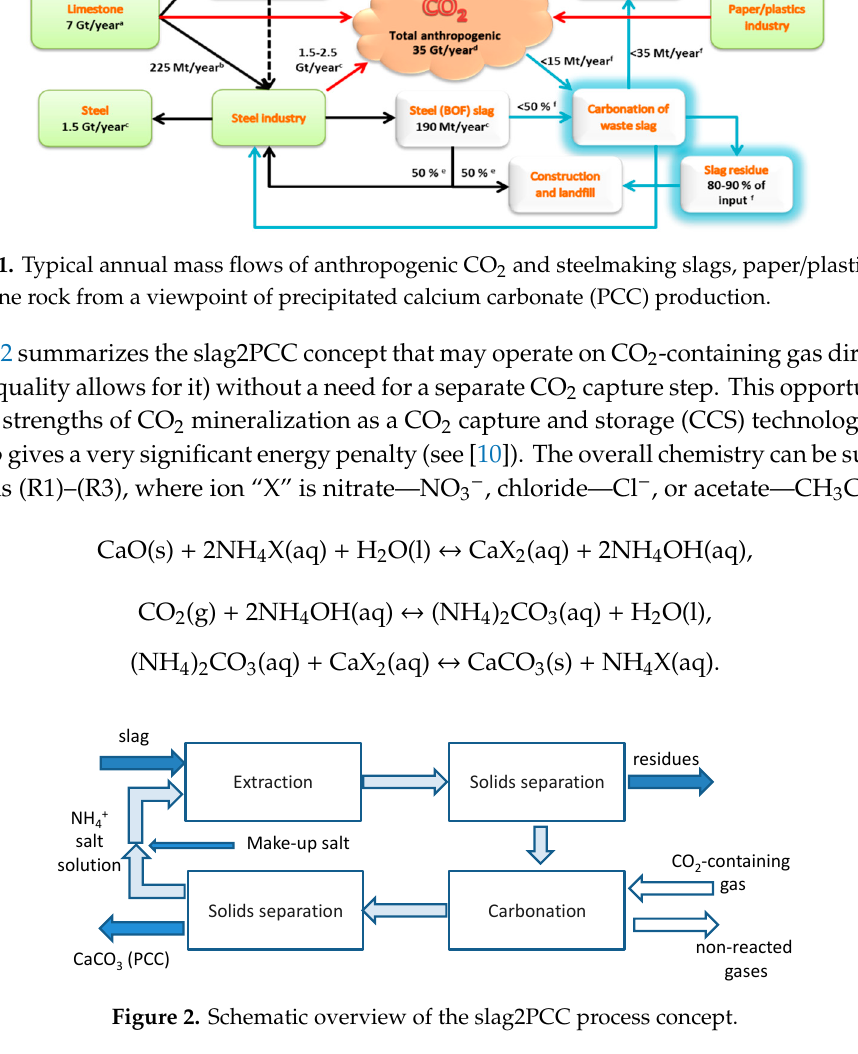
Figure 2. Schematic overview of the slag2PCC process concept.